Question: In a single sentence, describe what this figure presents.
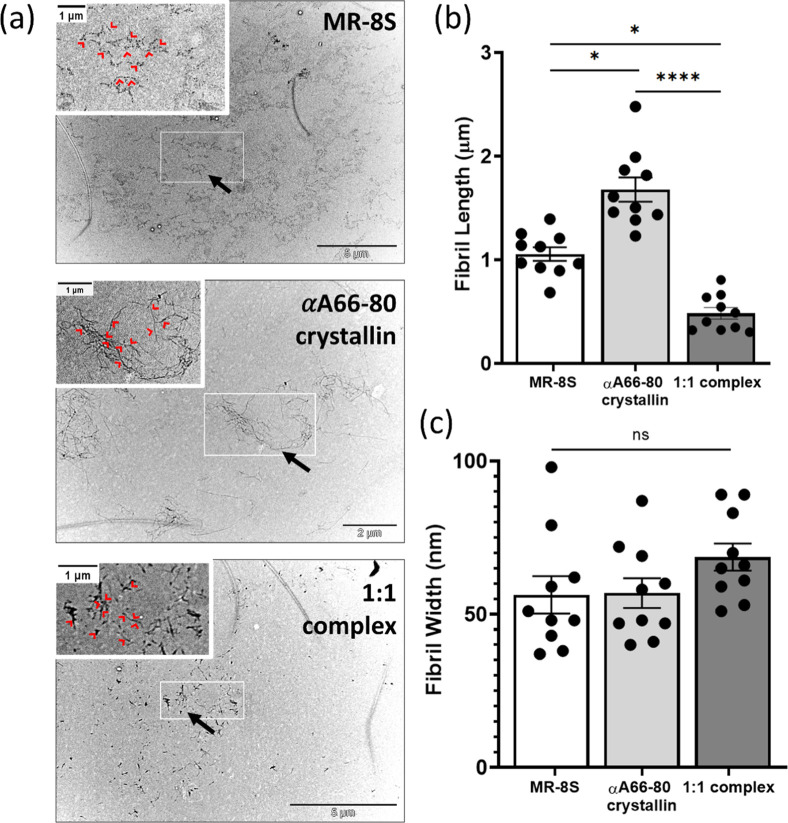
Answer: TEM images of αA66–80 Crystallin peptide aged ( t = 7d) (a) MR-8S , αA66–80 Crystallin peptide alone, and αA66–80 Crystallin peptide: MR-8S complexation (1:1 molar concentration ratio). Black arrows: showing morphological structures within each TEM image. Red arrows: specific fibrils used in width and length analysis. (b) Fibril length (μm) and (c) fibril width (nm) of aggregates in each respective sample, along with statistical significance. Data are presented as the mean ± SEM ( n = 10). Stats: Kruskal–Wallis test with Dunn’s multiple comparisons posthoc test * p < 0.05, **** p < 0.0001, ns = not significant.